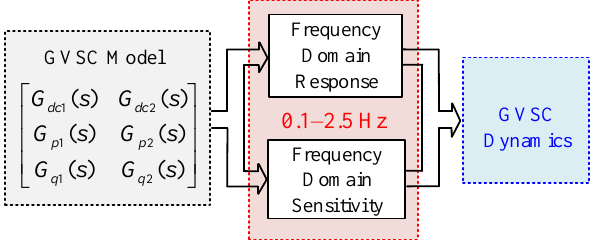
Figure 3. Frequency domain analysis for GVSC.